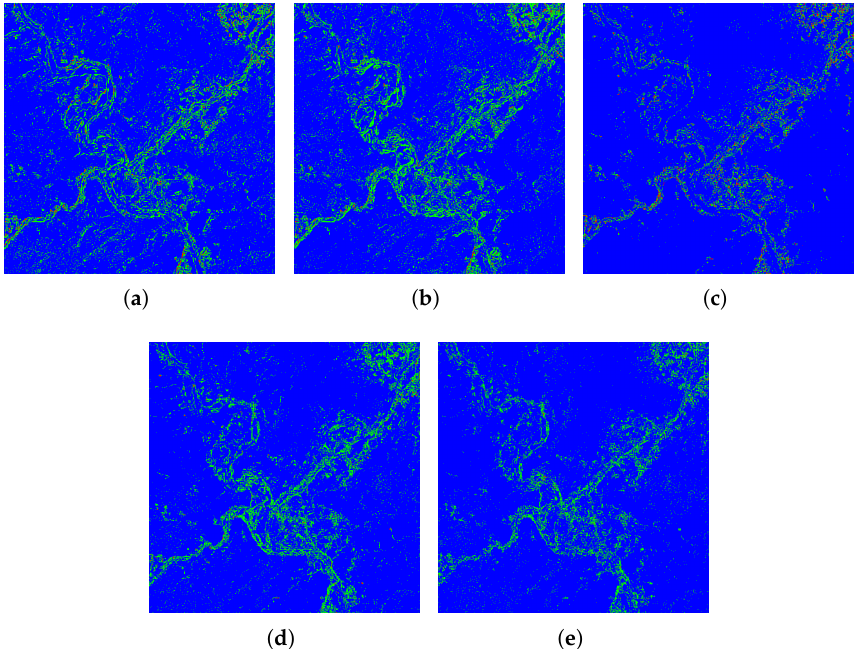
Figure 7. The difference image between the pan-sharpened image and the reference image of the IKONOS data, where red represents the large difference, blue the small difference, and green the middle difference. ( a ) AIHS; ( b ) ATWT; ( c ) PNN; ( d ) MSDCNN; ( e ) the proposed method.